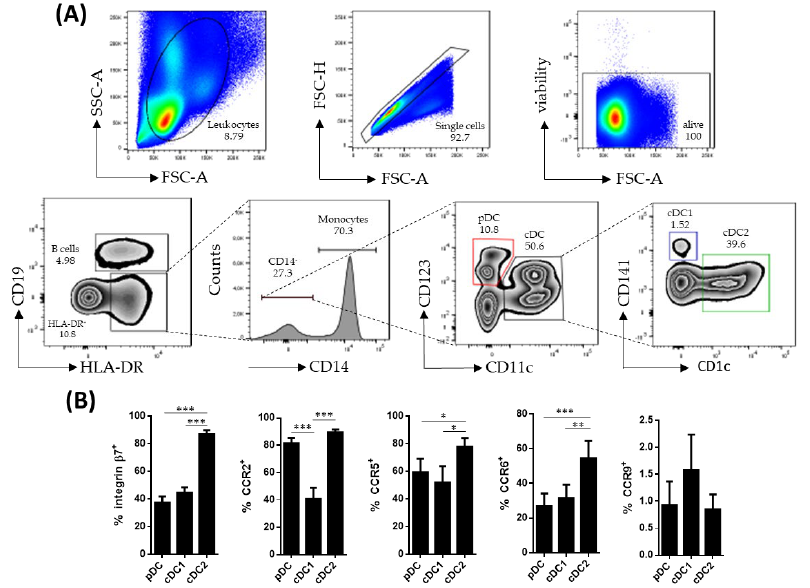
Figure 1. Characterization of circulating dendritic cell subsets. ( A ) Dendritic cell (DC) subsets were identified by flow cytometry within singlet viable peripheral blood mononuclear cells. HLA- DR + CD19 − CD14 − cells were further subdivided into plasmacytoid dendritic cells (pDCs) (CD123 + CD11c − ) and conventional dendritic cells (cDCs) (CD11c + ). The cDC cells were further divided based on the expressions of CD141 (cDC1) and CD1c (cDC2). ( B ) Phenotype of the different DC subsets from healthy controls was determined by analyzing the expressions of integrin β 7,